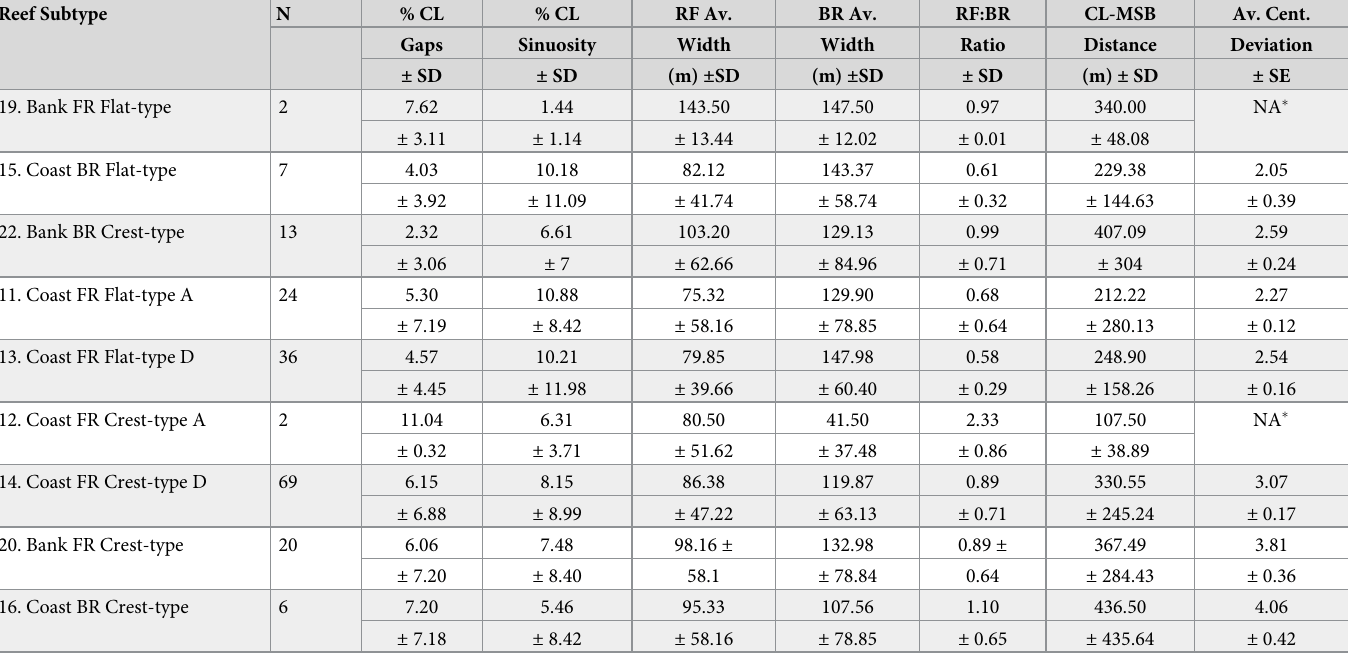
Table 2. Mean morphometric parameters of common reef subtypes. Internal morphological variation within each subtype is represented by the average deviation from the group centroid. Many morphometric variables have non-normal sampling distributions causing the standard deviation to be larger than the mean of the variable. Reef Subtype N % CL % CL RF Av.